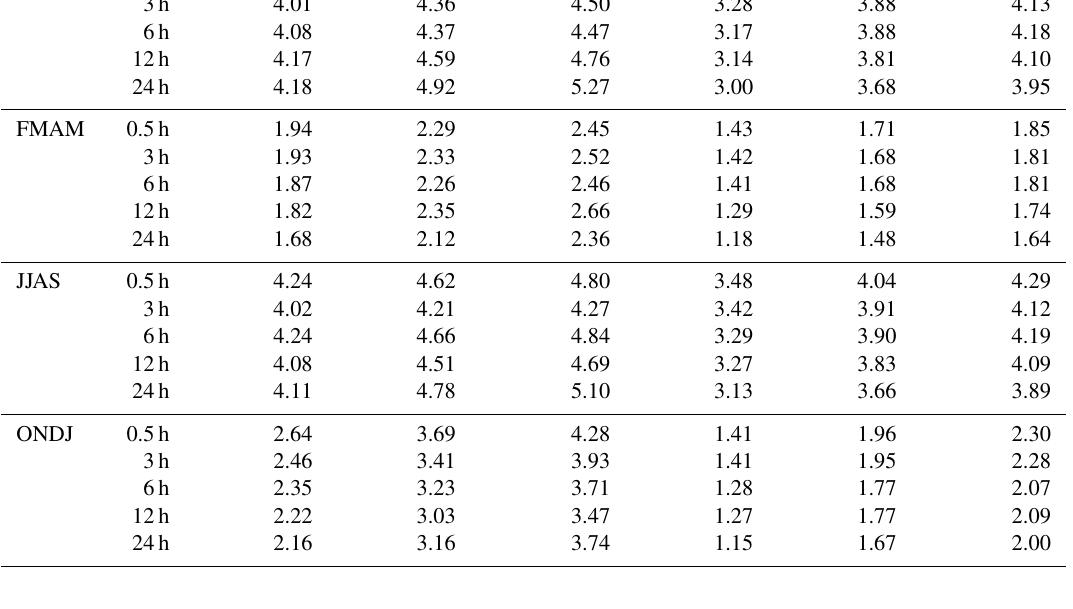
Table 4. Estimated return values corresponding to different seasons using total wave height ( H s ) following the GEV and GPD methods. Here the GEV method follows the initial distribution approach.